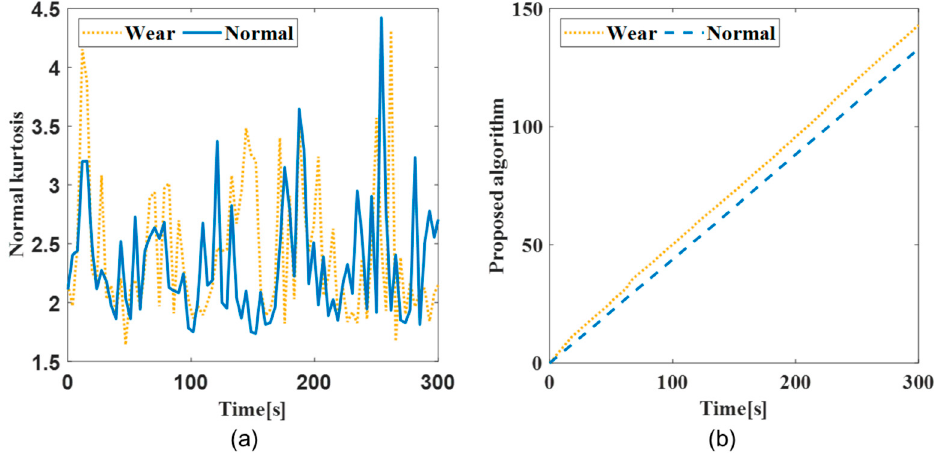
Figure 6. Difference between normal and wear tool in AI7075 machining process: ( a ) kurtosis; ( b ) kurtosis using proposed algorithm.